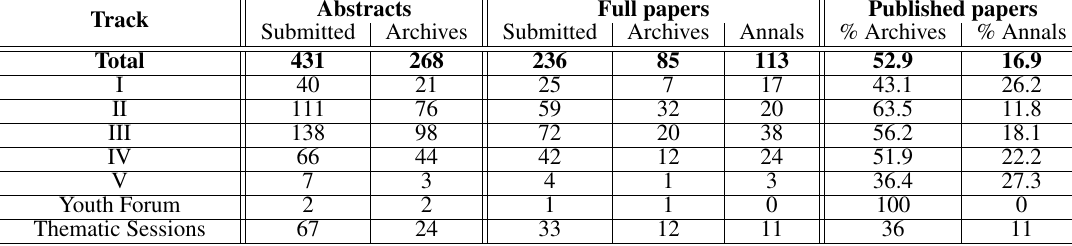
Table 2. Detailed statistics for each